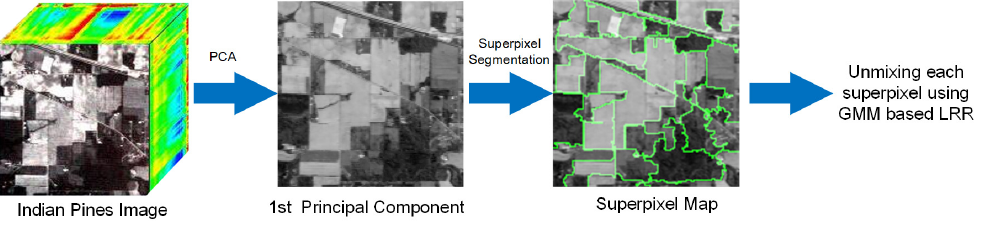
Figure 1. Algorithm flow of the proposed